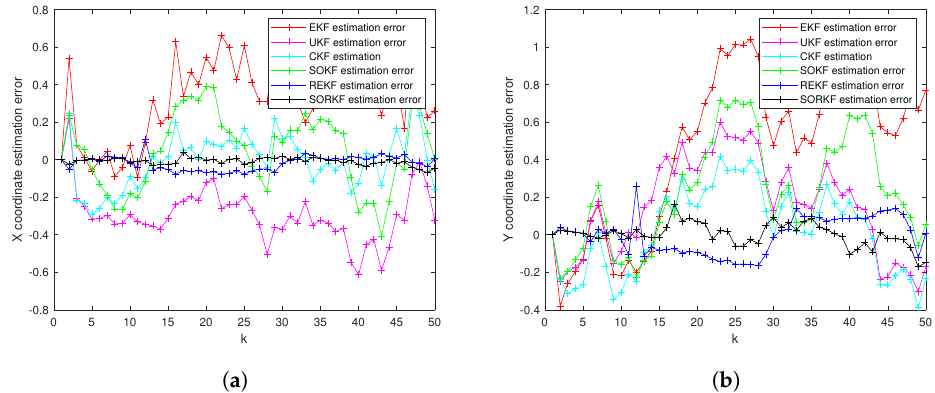
Figure 16. R3 estimation error of multi-robot swarm in random topology formation. ( a ) X-Coordinate estimation error; ( b ) Y-Coordinate estimation error.